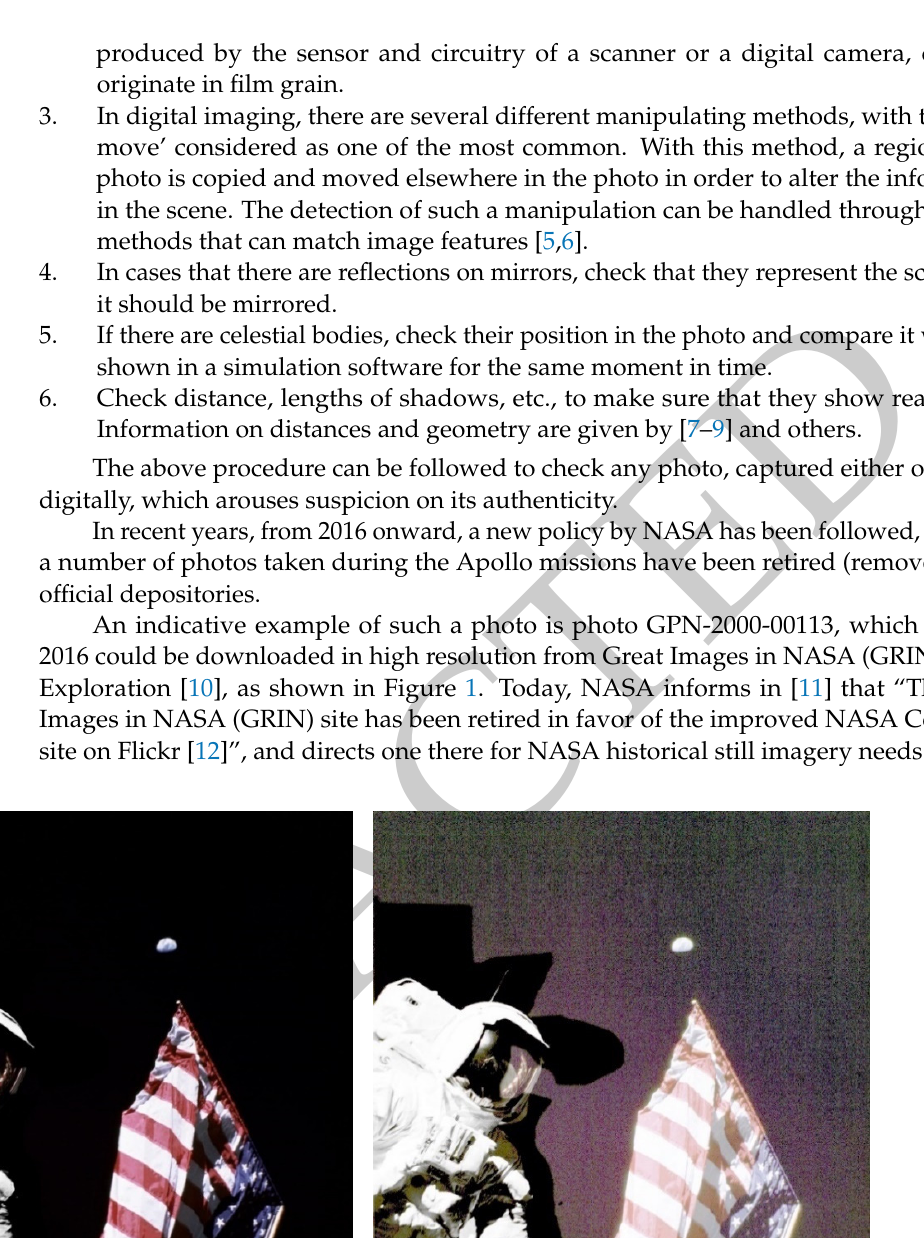
( b ) Figure 2. AS17-134-20384, found in: ( a ) the project Apollo archive of flickr.com [13]; ( b ) the Apollo 17 Image Library [16]. A logical question that arises is whether, 50 years after the events, it is worth trying to prove the authenticity or the falsity of a photo. We believe that the matter is serious enough, because the specific photo is one of a series of photos related to a monumental “feat” of the whole of humankind, which led humans to walk on another celestial body for the first time. Photographic evidence was the main undeniable tool used to persuade common people about the authenticity of the missions. It may matter even more to older generations who “proudly” followed all missions and saw their fellow humans (the as- tronauts) risking their lives. The moon landing has also been an important part of narra- tives in history classes for the new generations. Nowadays, no human lives should be risked for such missions, as technology has advanced so much that robots can do a better job and acquire much more data per mission, although not generating as much public excitement.